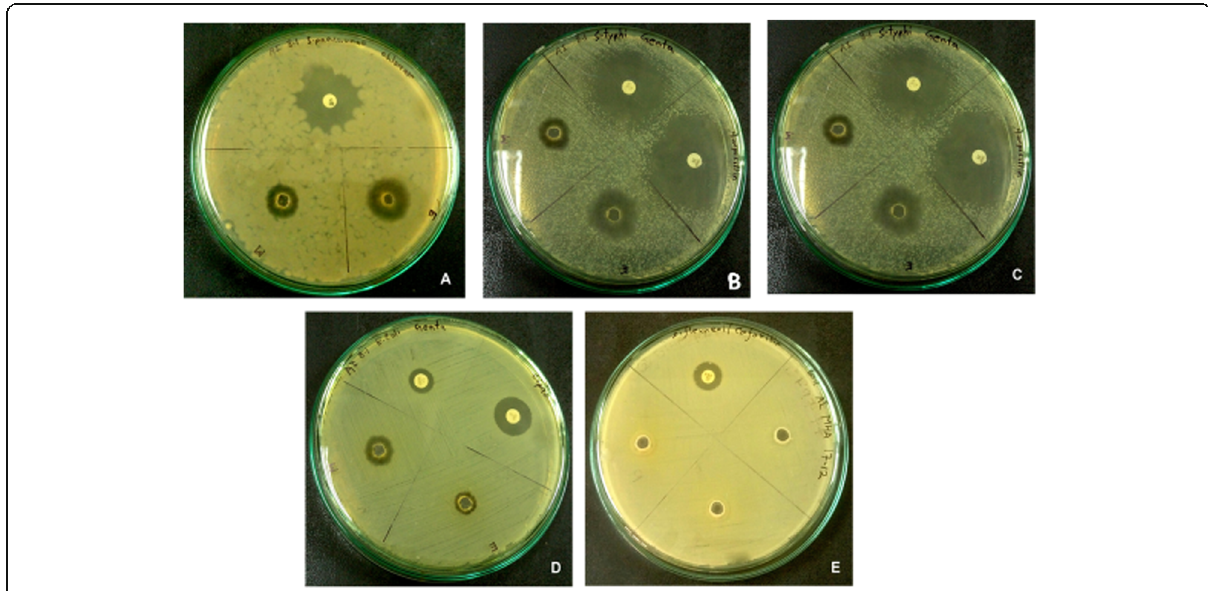
Fig. 4 Antibacterial effects of ethanolic and methanolic extracts of Heptapleurum hypoleucum against. a S. pneumonae. b S. aureus . c S. typhii . d E. coli. e Shigella flexneri. Ethanolic extract showed the highest zone of inhibition against Staphylococcus aureus (21 mm). Each of the plates is also showing the zone (white) produced by the commercial antibiotics against respective bacteria (as mentioned in Table 3)